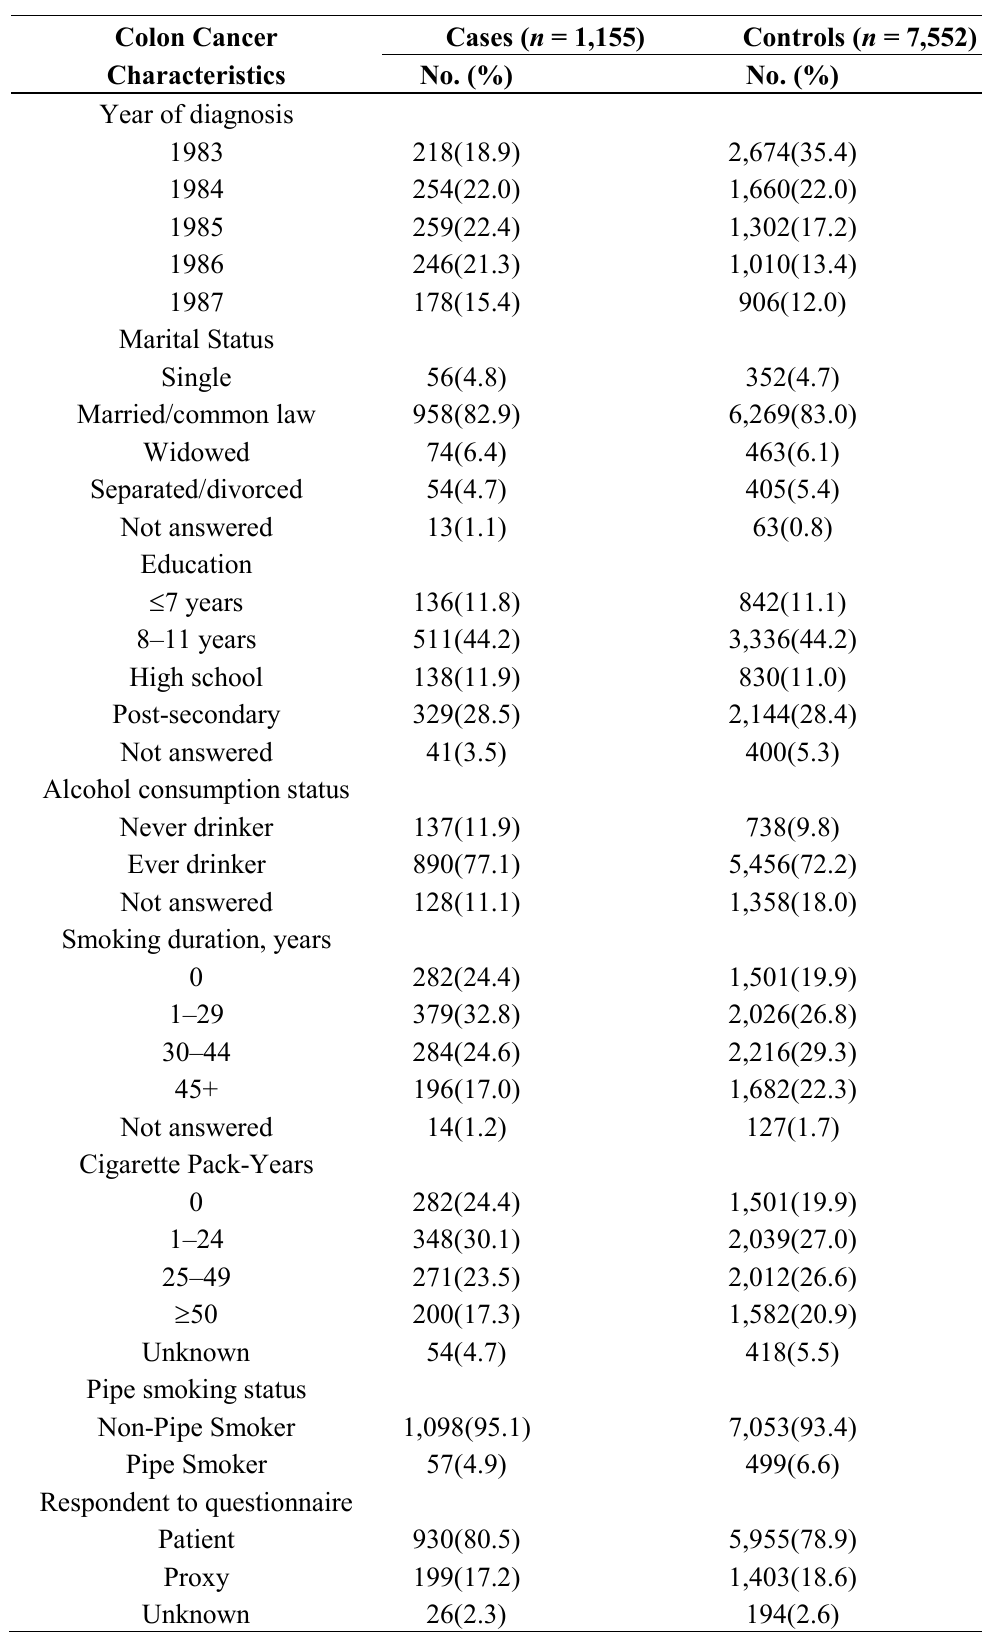
Table 2. Characteristics of cases and